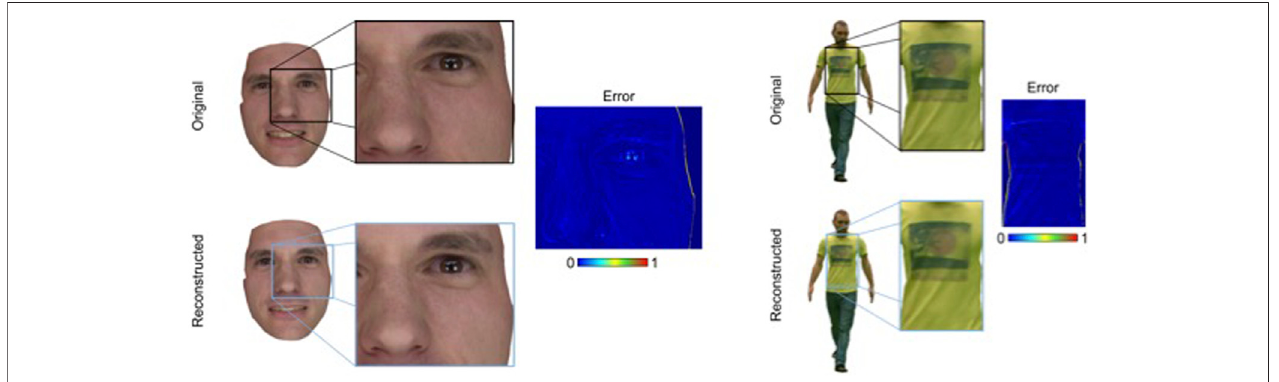
FIGURE 10 | The images represent the same motion frame, the top images were rendered using the original geometry and texture appearance, and the bottom imageswere rendered usingthegenerativenetworks.Theerrorimage isanerrorhistogram between theoriginaland resulted images. Itisvisible fromthereconstructed that it preserves original details such as, re fl ection on the eye ball, clothing patterns and wrinkles.